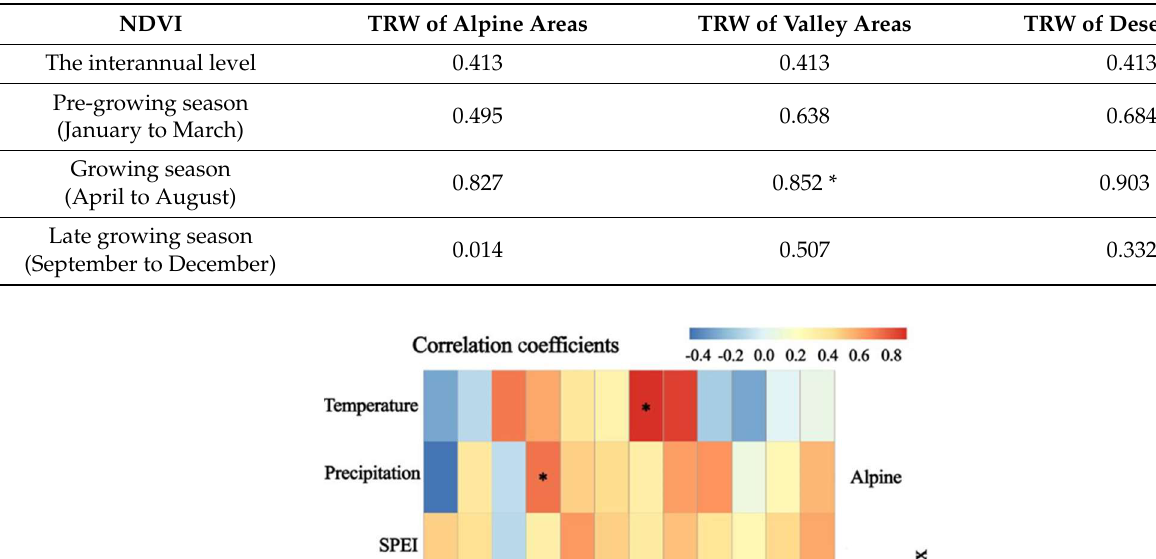
Table 3. Correlation between TRW and NDVI. Note: * p < 0.05.